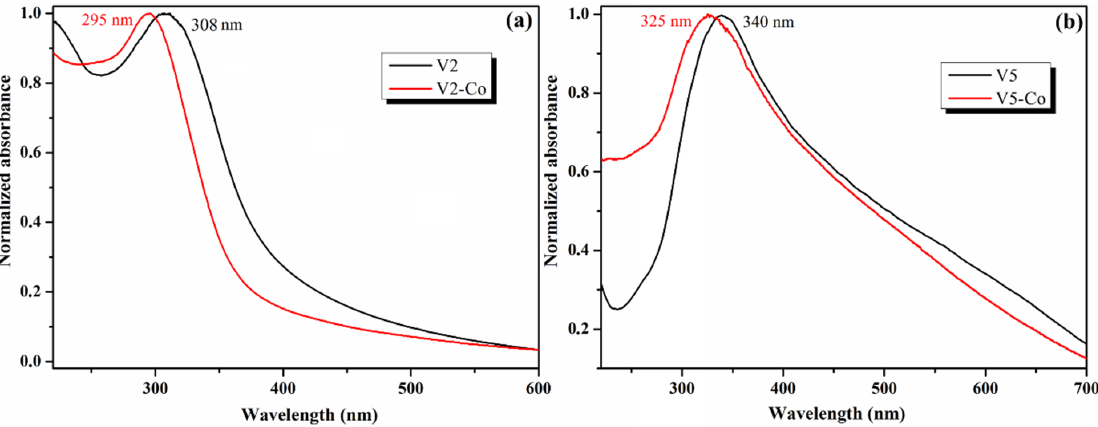
Figure 7. UV–Vis absorption spectra of V2 samples, pristine and Co-doped ( a ), and of V5 samples, pristine and Co-doped ( b ).